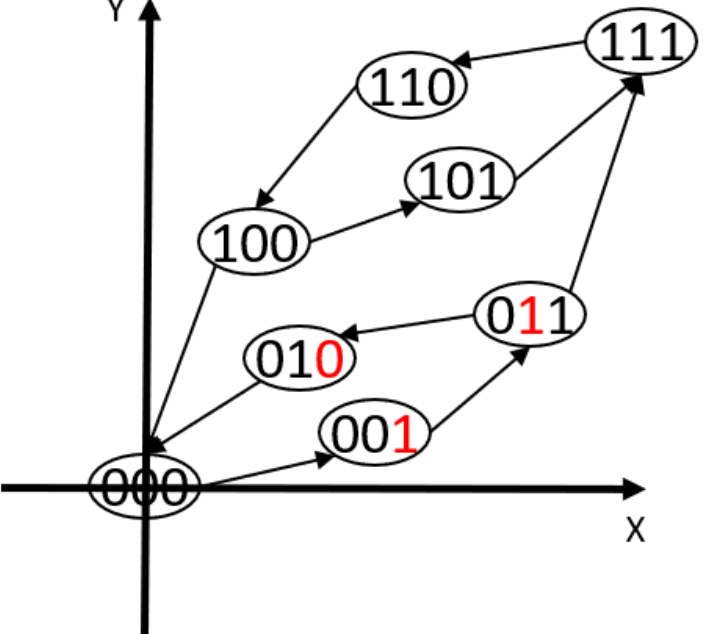
Figure 2. A digitized representation of the classical PI hysteresis model with three